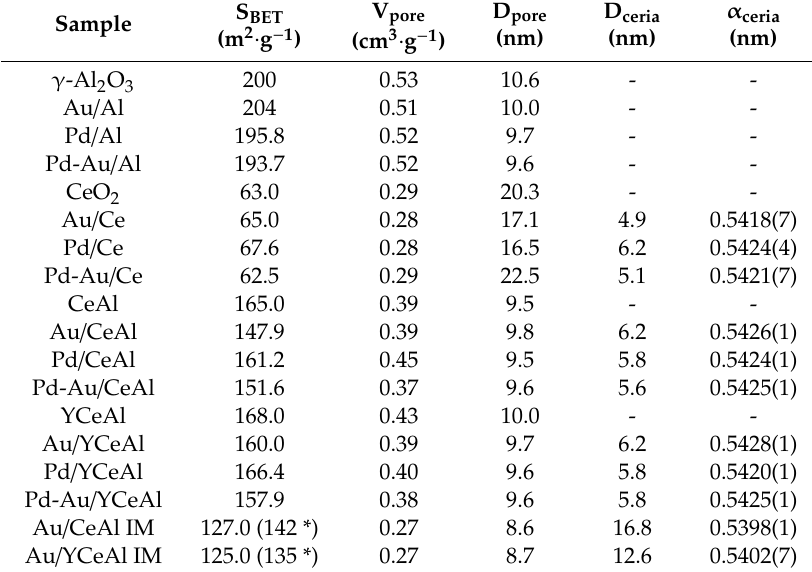
Table 1. Specific surface area (S BET ), pore volume (V pore ), pore size (D pore ), average size (D ceria ) and lattice parameter ( α ) of ceria estimated by